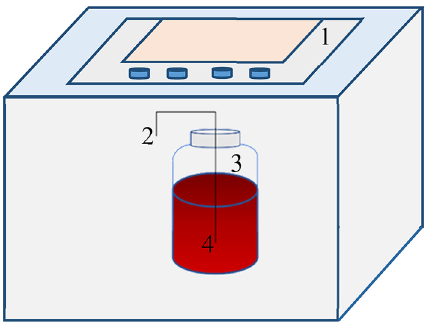
Figure 1. Schematic diagram of the reactor system: (1) Control panel for rotation speed and temperature, (2) sludge sample, (3) N 2 , and (4) serum bottle (with or without